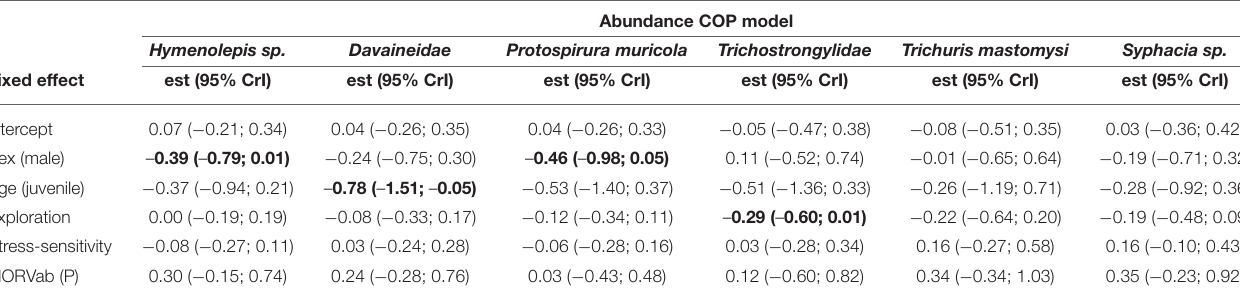
TABLE 3 | Posterior mean responses (with their 95% credibility intervals) of the different helminth species to the fixed effects derived from the abundance COP